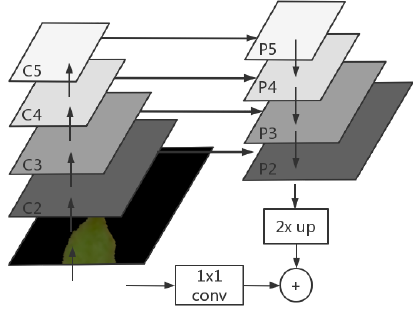
Figure 4. The FPN network structure diagram.